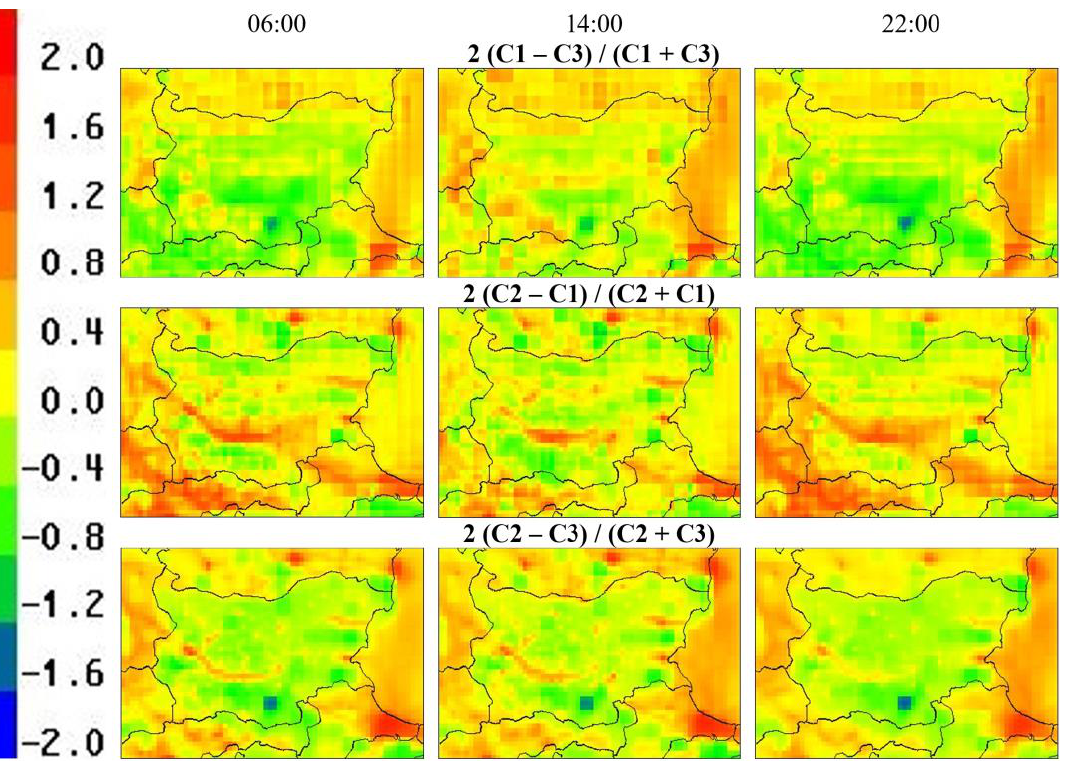
Figure 4. Annually averaged relative differences of the surface concentrations of SO 2 between cases C1 and C3, C2 and C1, C2 and C3 respectively.